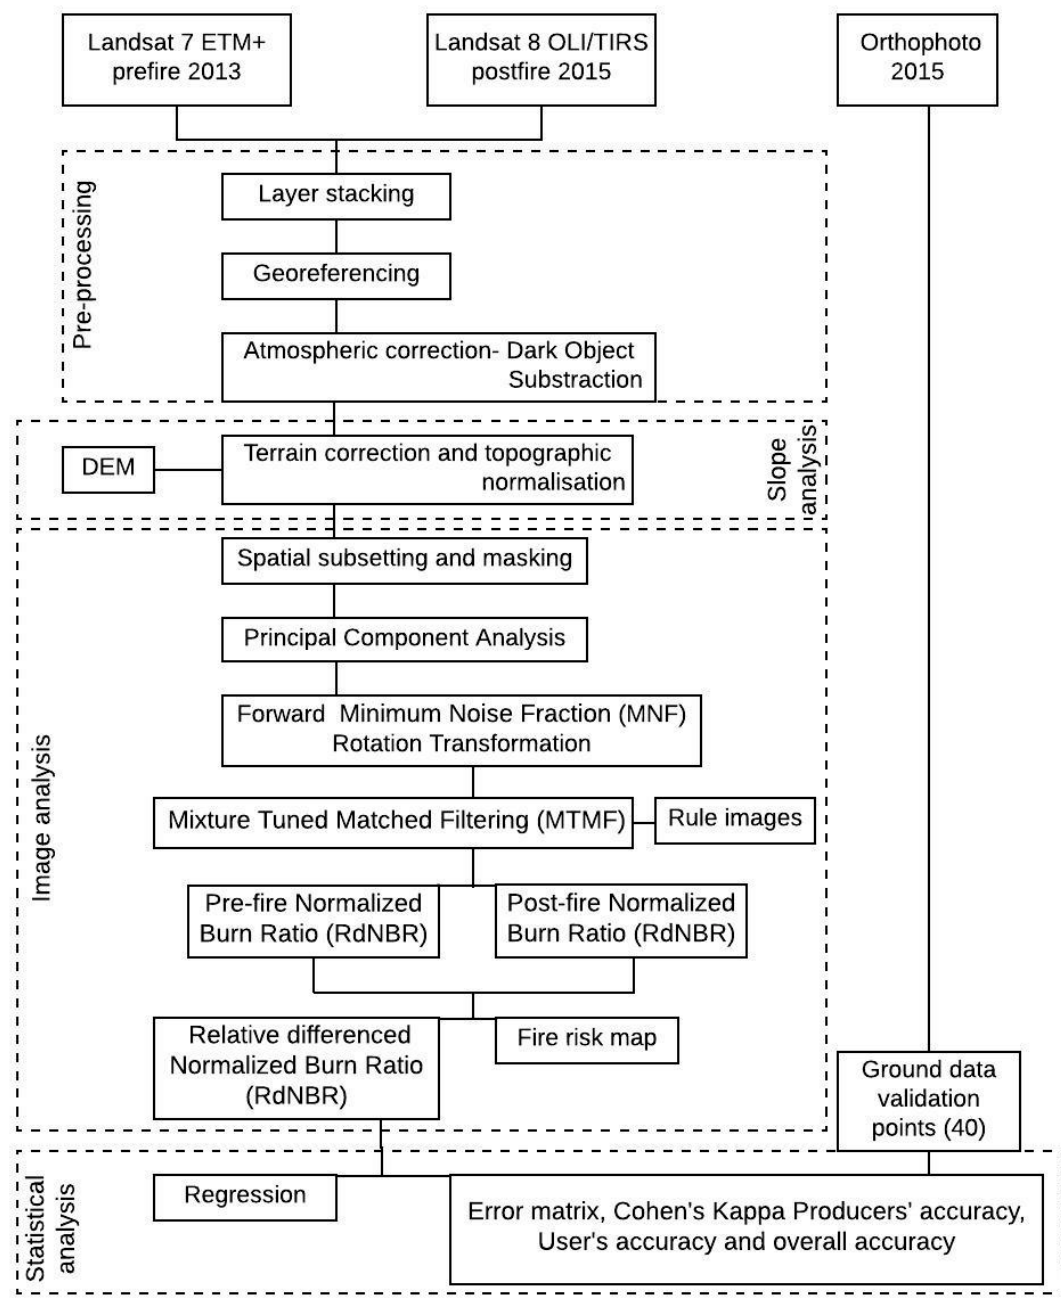
Figure 2. Flowchart for the overall methodology of the burn severity mapping in the Palo Verde National Park, Costa Rica.